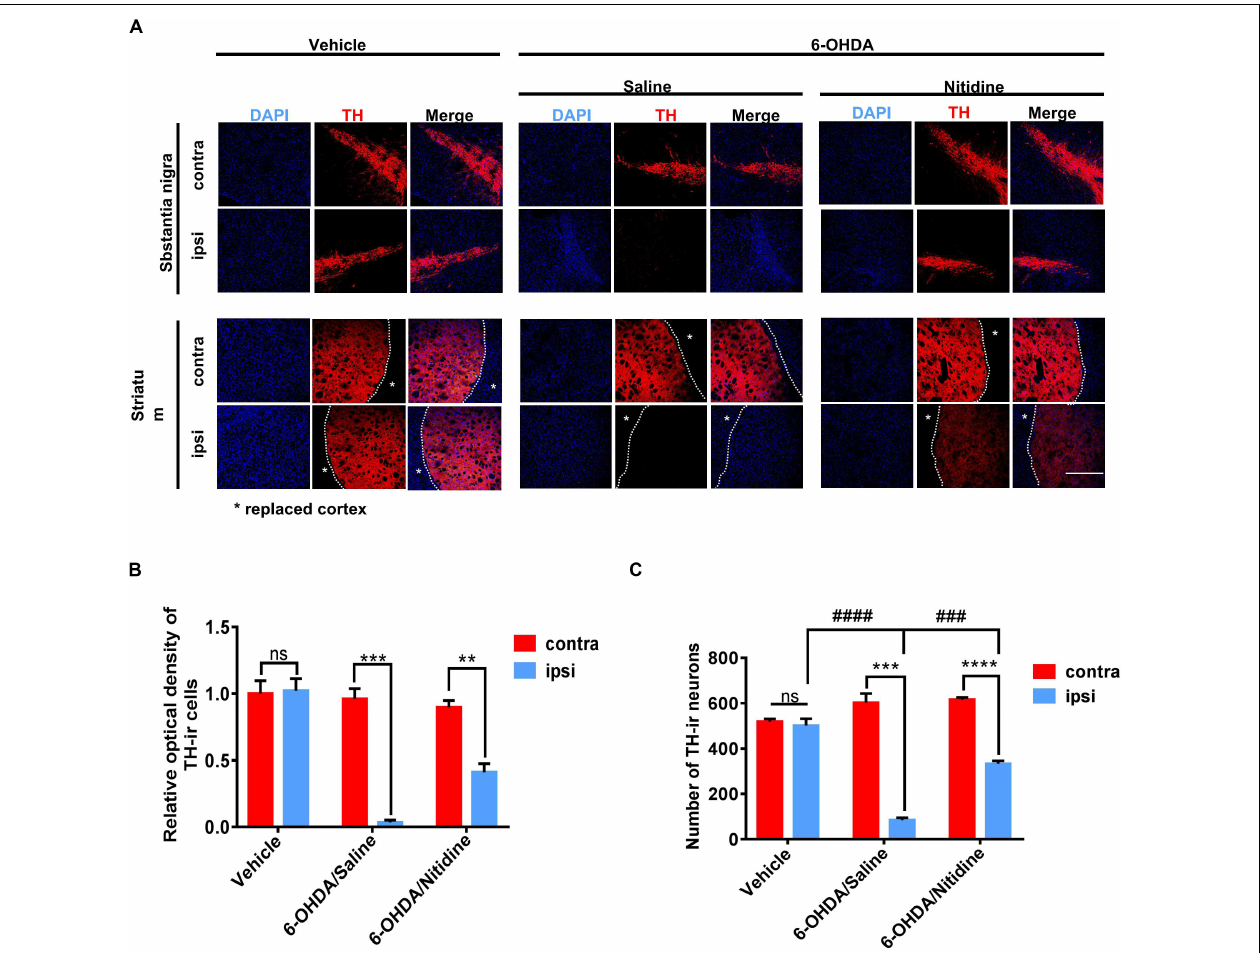
FIGURE 3 | Dopaminergic neuron survival in Parkinson’s disease (PD) models following treatments. (A) Tyrosine hydroxylase (TH)-immunoreactive neurons (red) in the PD rats. Scale bar depicts 500 µ m. (B) Statistical result of optical density values of TH-ir cells in SN ( t -test). Vehicle group: P = 0.8816, t = 0.1587, df = 4, F = 1.144. 6-Hydroxydopamine (6-OHDA)/saline: P = 0.0003, t = 11.86, df = 4, F = 18.13. 6-OHDA/nitidine: P = 0.0043, t = 5.853, df = 4, F = 1.571. (C) Statistical result of TH-ir cell numbers in SN ( t -test). Vehicle group: P = 0.6134, t = 0.5472, df = 4, F = 6.356. 6-OHDA/saline: P = 0.0002, t = 12.47 df = 4, F = 14.23. 6-OHDA/nitidine: P < 0.0001, t = 17.85, df = 4, F = 1.652. Comparison between ipsilateral sides: one-way ANOVA. P < 0.0001, F = 113.8. *Comparison between contralateral and ipsilateral from a single group. # Comparison between different groups. ns P > 0.05, # P < 0.05, #### P < 0.0001, ** P < 0.01, *** P < 0.001, **** P <